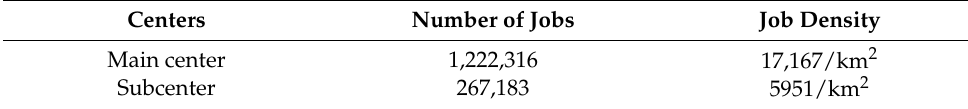
Figure 5. The main center and subcenter in Tianjin metropolitan area. Table 1. The number of jobs and job density of centers in Tianjin metropolitan area.